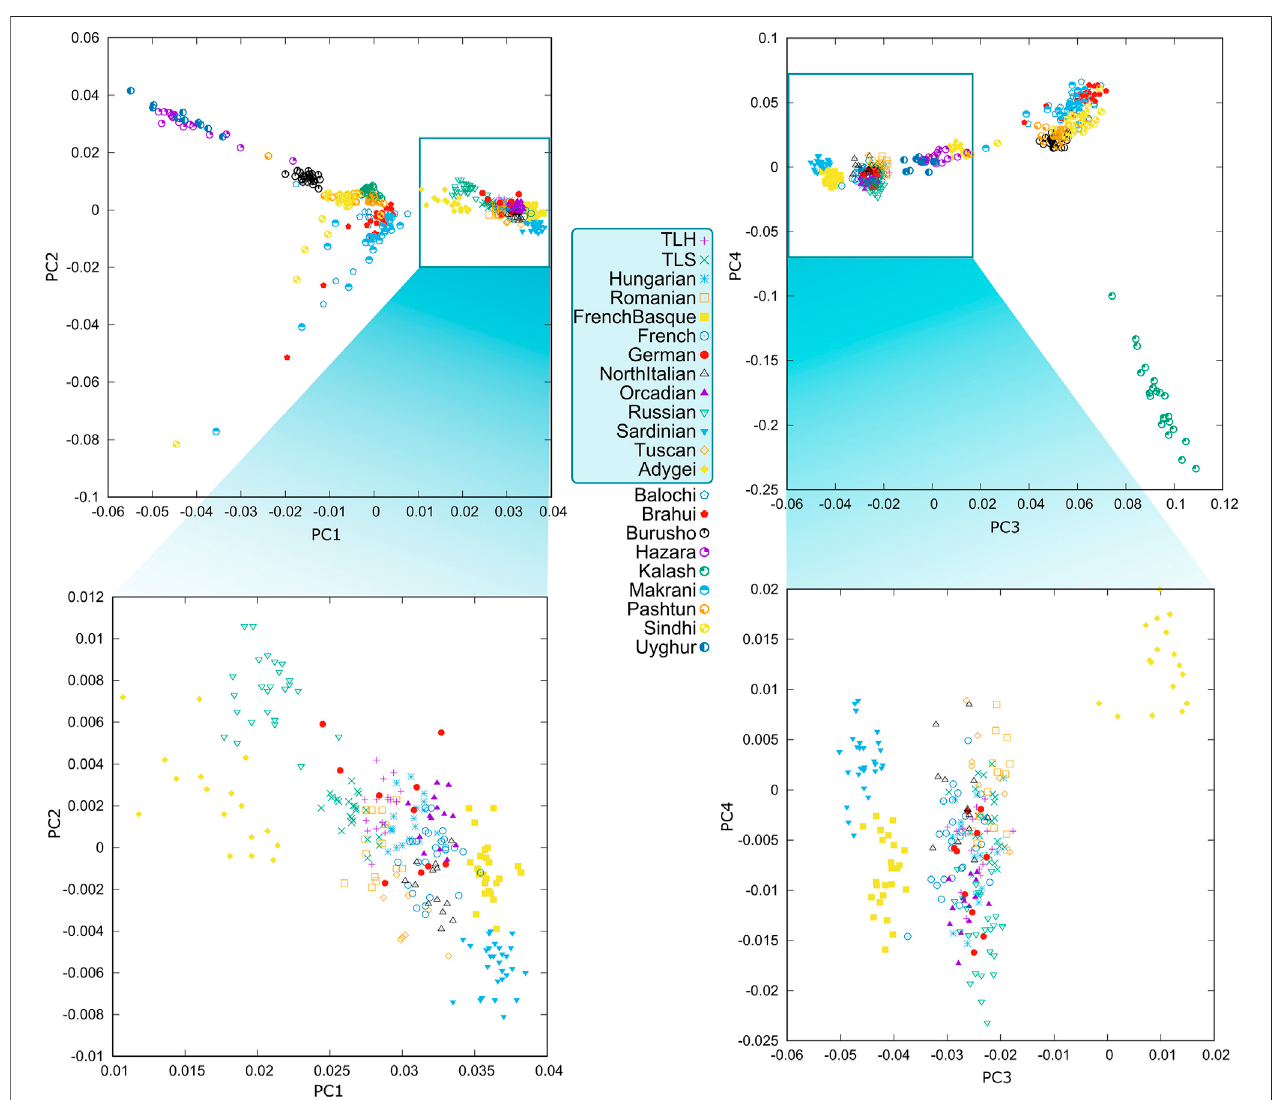
FIGURE 1 | PCA results plotted on the fi rst four eigenvectors. Eigenvalues of the fi rst four principal components were 20.711, 14.184, 6.219, and 3.243, respectively. PCA featuring only 13 populations is the result of the same analysis plotting only the respective populations. TLH — Transylvania-living Hungarians; TLS — Transylvania-living